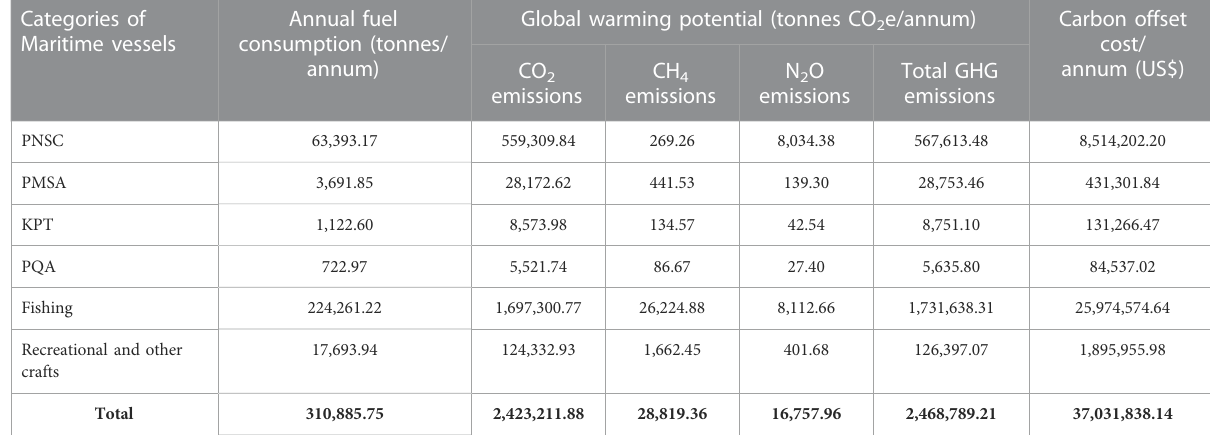
TABLE 8 Global Warming Potential (GWP, CO 2 e) from each category of maritime vessels and respective carbon offset cost.